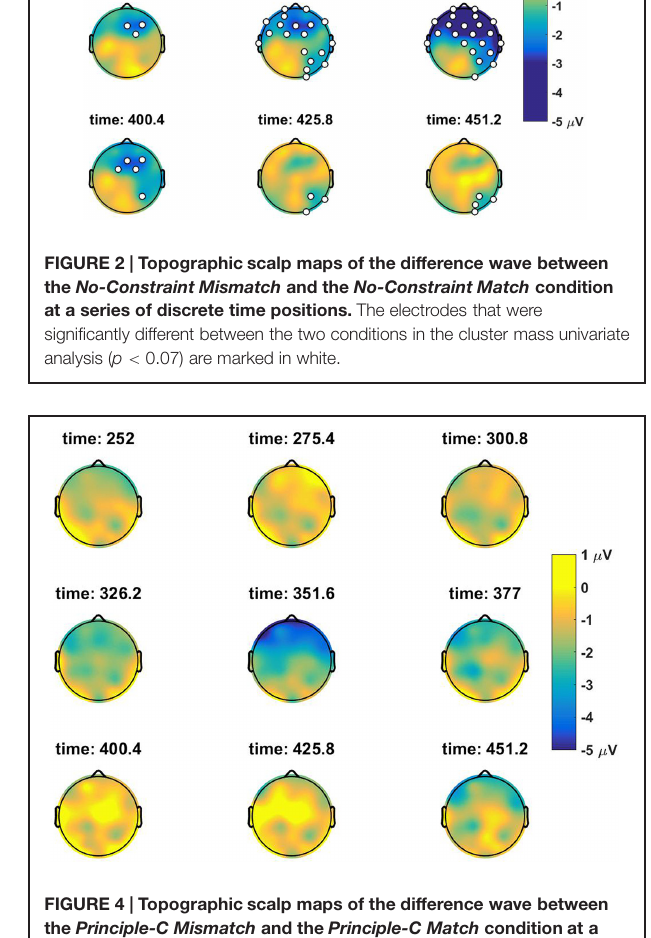
all samples between 200 and 800 ms at all 32 electrodes.